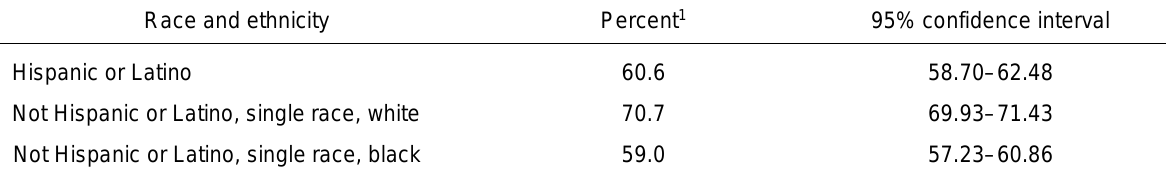
Data table for Figure 11.4. Age-sex-adjusted percentage of persons of all ages who had excellent or very good health, by race and ethnicity: United States,